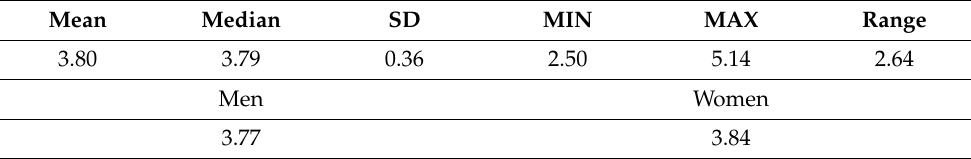
Table 1. Mean, median, standard deviation, minimum, maximum, and range of J.S. Mean